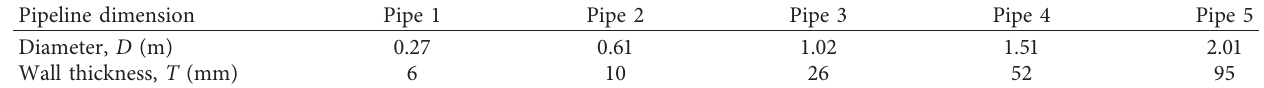
Table 1: Summary of pipeline dimension parameters.